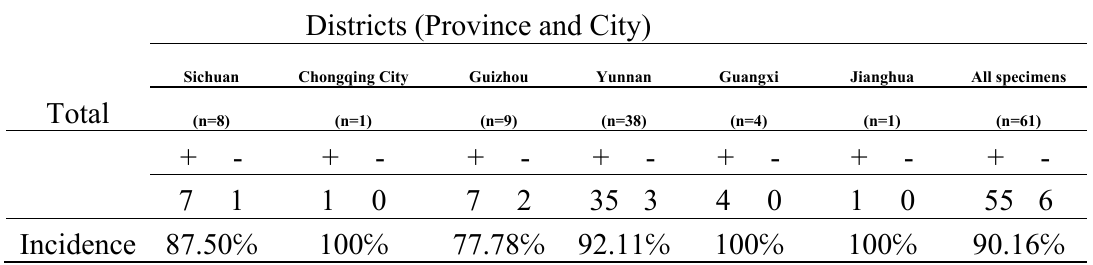
Table 1. SRBSDV incidence of suspected samples from Southwestern China Districts (Province and